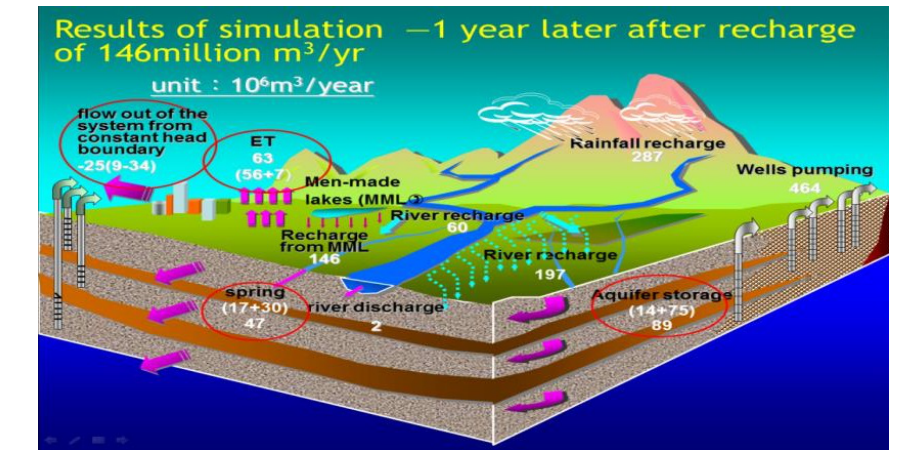
Figure 6. Artificial groundwater recharge using the MODFLOW model (CTCI,